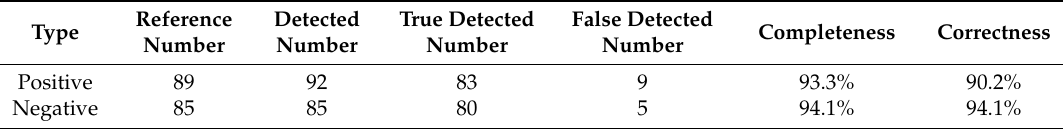
Table 2. The building change detection results of the proposed